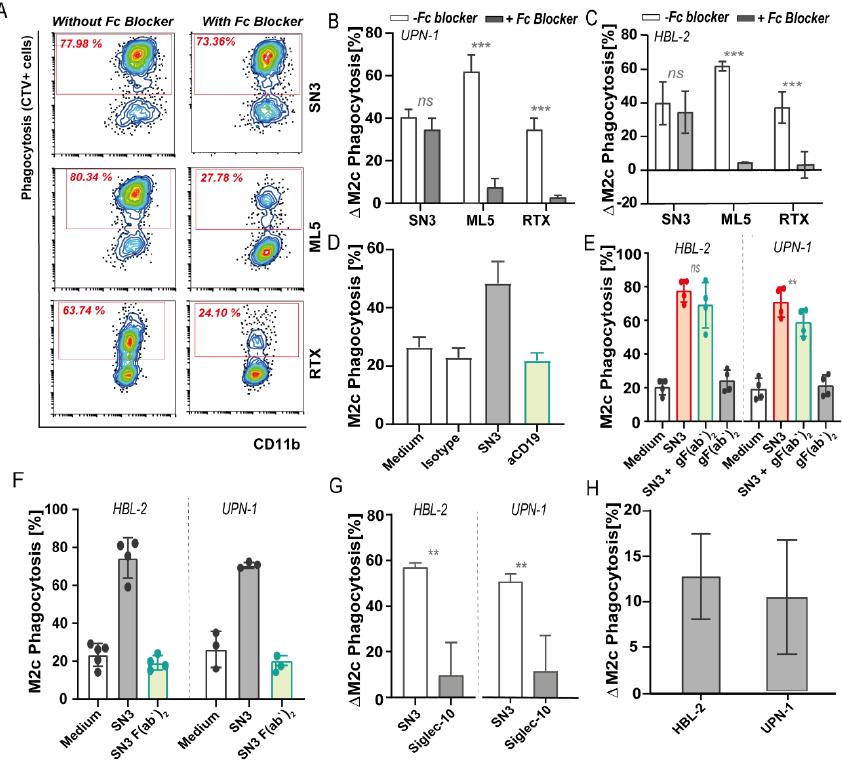
Figure 5. CD24 antibody treatment with two different murine anti-CD24 clones (SN3 and ML5) and Siglec-10 disruption of CD24/Siglec10 axis. ( A ) Flow cytometry diagrams showing the percentage of phagocytosis of UPN-1 cells upon CD24 antibody treatment with SN3 and ML5 clones by M2c macrophages in the presence or absence of high concentrations of Fc blocker. Rituximab (RTX) (anti- CD20) antibody was used as a control. ( B ) Increase in phagocytosis compared to medium control of UPN-1 cells upon CD24 antibody treatment with SN3 and ML5 antibody clones by M2c macrophages in the presence (gray) or absence (white) of high concentrations of Fc blocker. ( C ) Increase in phagocytosis compared to medium control of HBL-2 cells upon CD24 antibody treatment with SN3 and ML5 antibody clones by M2c macrophages in the presence (gray) or absence (white) of high concentrations of Fc blocker. n = 3, mean ± SD. Paired t -test, with p < 0.05 significant. ( D ) Phagocytosis of HBL-2 cells upon anti-CD24 (1 µ g/mL, red) or anti-CD19 (10 µ g/mL, green) treatment, being both mouse IgG1 antibodies. ( E ) Phagocytosis of HBL-2 and UPN-1 cells upon anti- CD24 treatment (SN3 clone) (red), same antibody pre-incubated with goat F(ab’) 2 against mouse IgG Fc domain (gF(ab’) 2 ) (green) or the goat F(ab’) 2 alone (gray). Paired t -test, with p < 0.05 significant. ( F ) Phagocytosis levels of HBL-2 and UPN-1 cells upon CD24 SN3 treatment with the complete antibody (red) or F(ab’)2 preparations of the same antibody clone (SN3) (green). ( G ) Phagocytic uptake by M2c macrophages upon CD24 treatment with recombinant human Siglec-10 (His tagged) protein of HBL-2 and UPN-1 cells. ( H ) Increase in phagocytosis compared to medium control of HBL-2 and UPN-1 cells co-cultured with M2c macrophages previously incubated with 10 µ g/mL of anti-Siglec-10 antibodies (5G6 clone). n = 3, mean ± SD. Where indicated, n.s. = non-significant, ** = p < 0.01; *** = p <